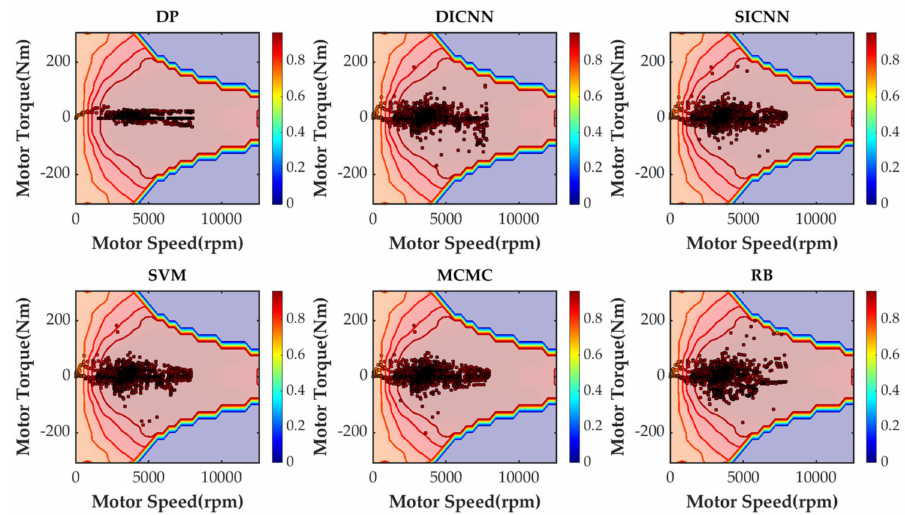
Figure 18. The distribution area of motor operating points under various strategies.